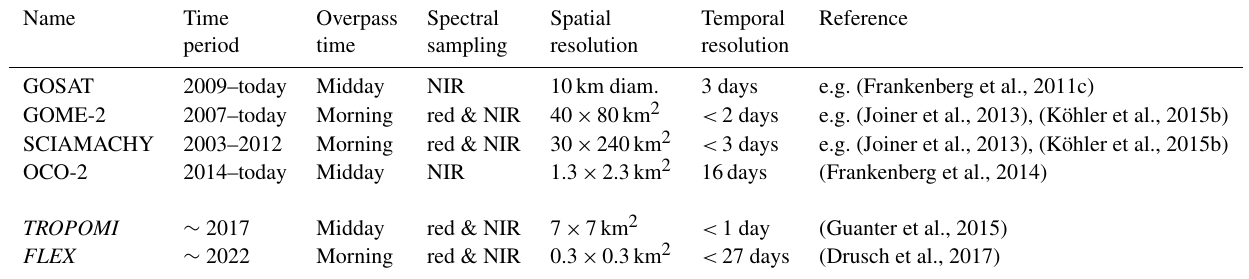
Table 3. Selected characteristics of operating and planned space-borne instruments able to deliver SIF data. Names of upcoming instruments are highlighted in italics. NIR stands for near-infrared. It must be noted that GOME-2 on MetOp-A has been operating with a reduced pixel size of 40 × 40km 2 since July 2013. References are examples: the full list is given in the